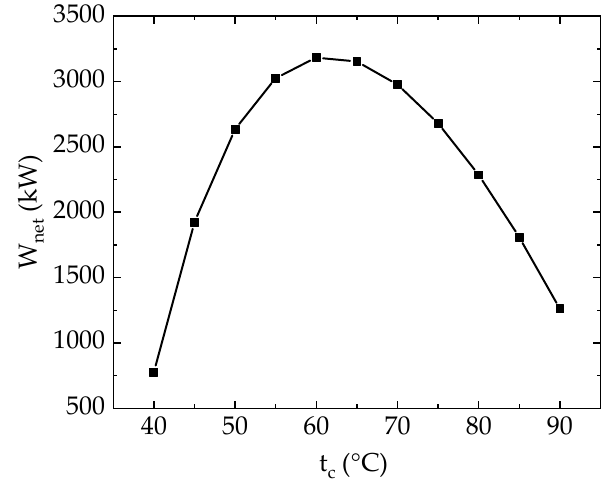
Figure 5. Influence of t c on net output power of B-ORC.